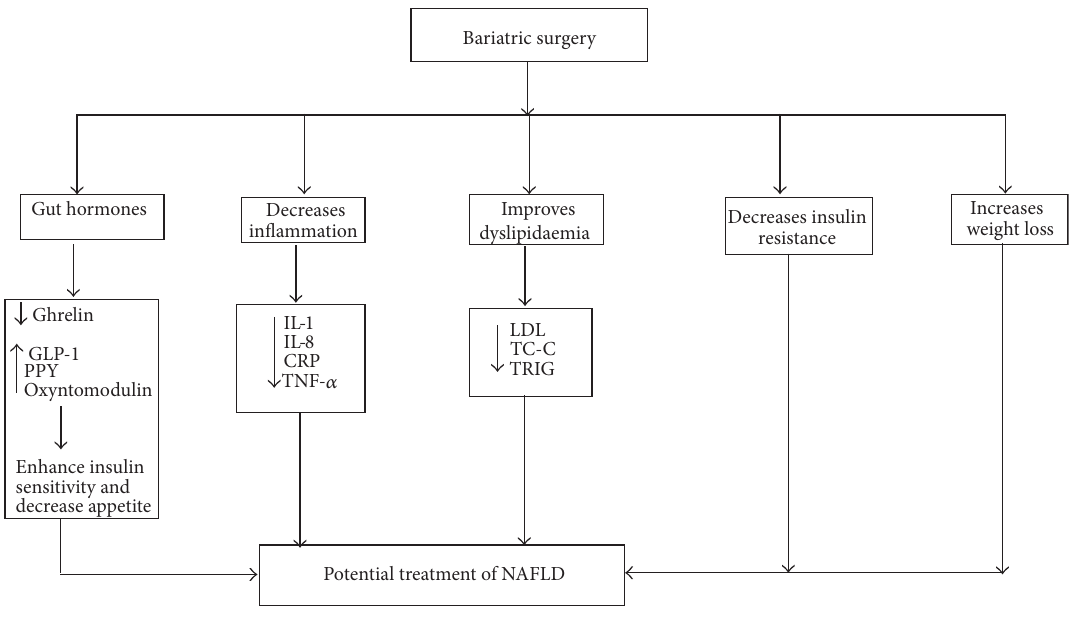
F 1: Schematic �gure illustrating the complex potential factors that associated with bariatric surgery that may have the potential role in the treatment of